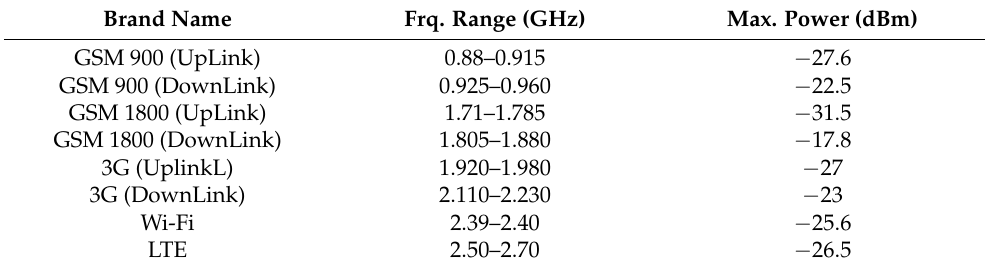
Table 1. Summary of RF survey at MMU.